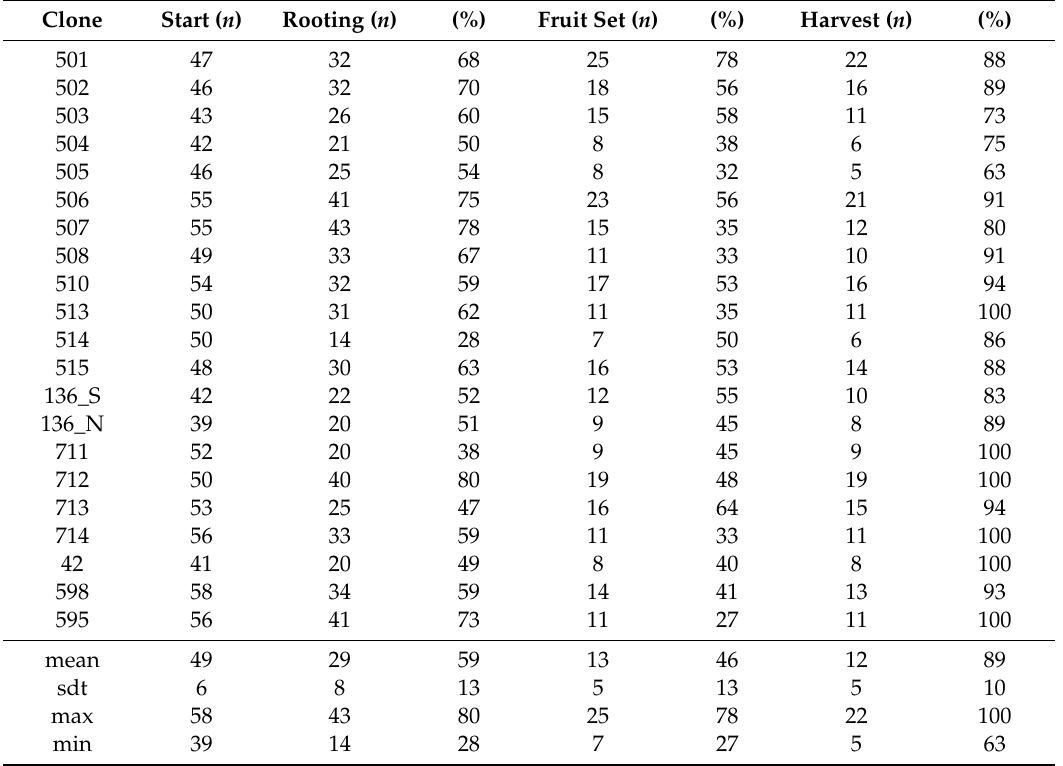
Table 1. Clone names, number of cuttings at the start, rotting, fruit-set, and harvest stages of the